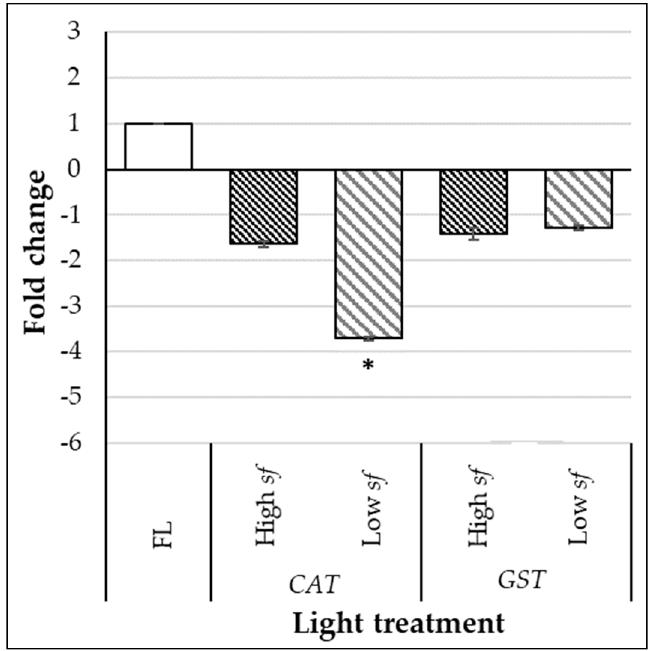
Figure 5. Effect of different lighting treatments on the expression of genes encoding for antioxidant enzymes in lettuce leaves ( n = 3) expressed as fold ‐ changes relative to the fluorescent light (FL, arbitrarily set at 1). CAT = catalase; GST = glutathione s ‐ transferase. Vertical bars represent standard errors. * indicates significant differences at p ≤ 0.05.